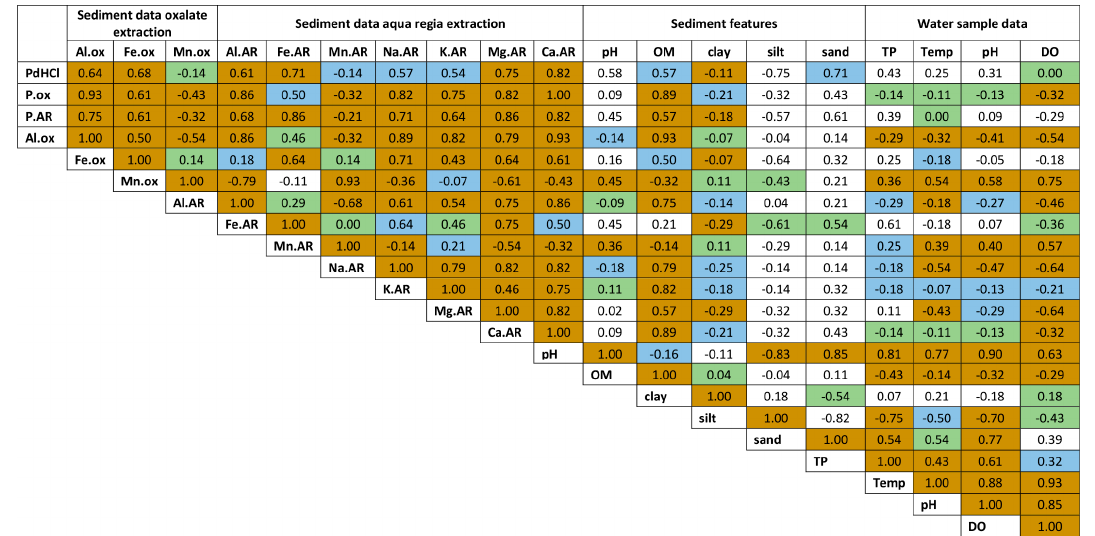
Figure A2. Spearman correlation of sediment and water data for Sampling 2 (15 March 2019). p ≤ 0.05 (green), p ≤ 0.01 (blue) and p ≤ 0.001 (brown), not significant (no color).